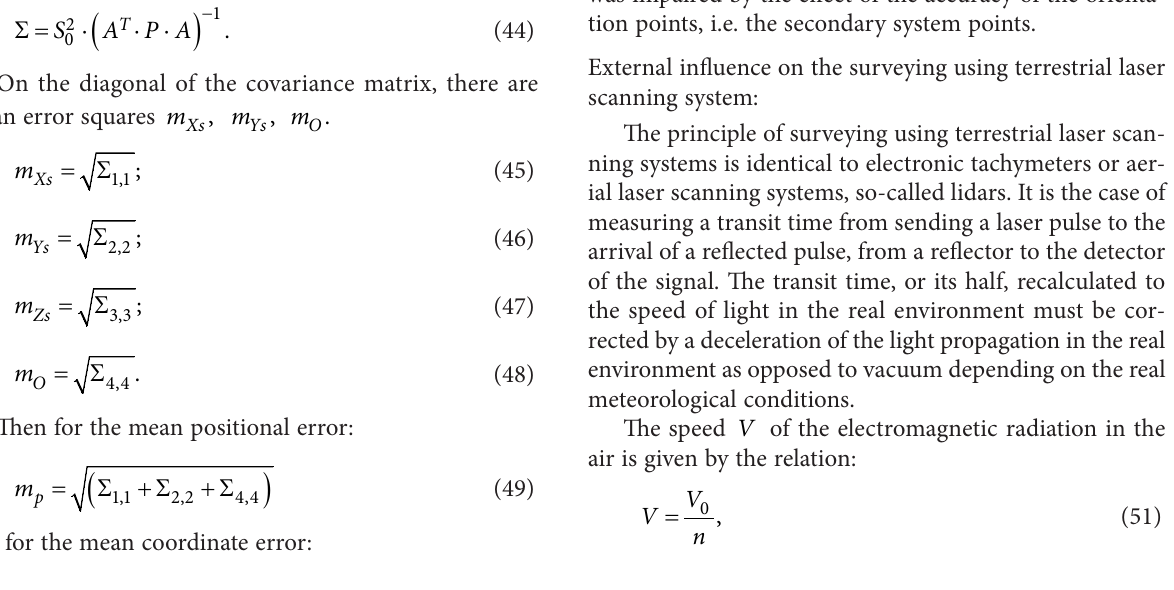
Table 3. The accuracy of the determination of free stations above the bearings Point